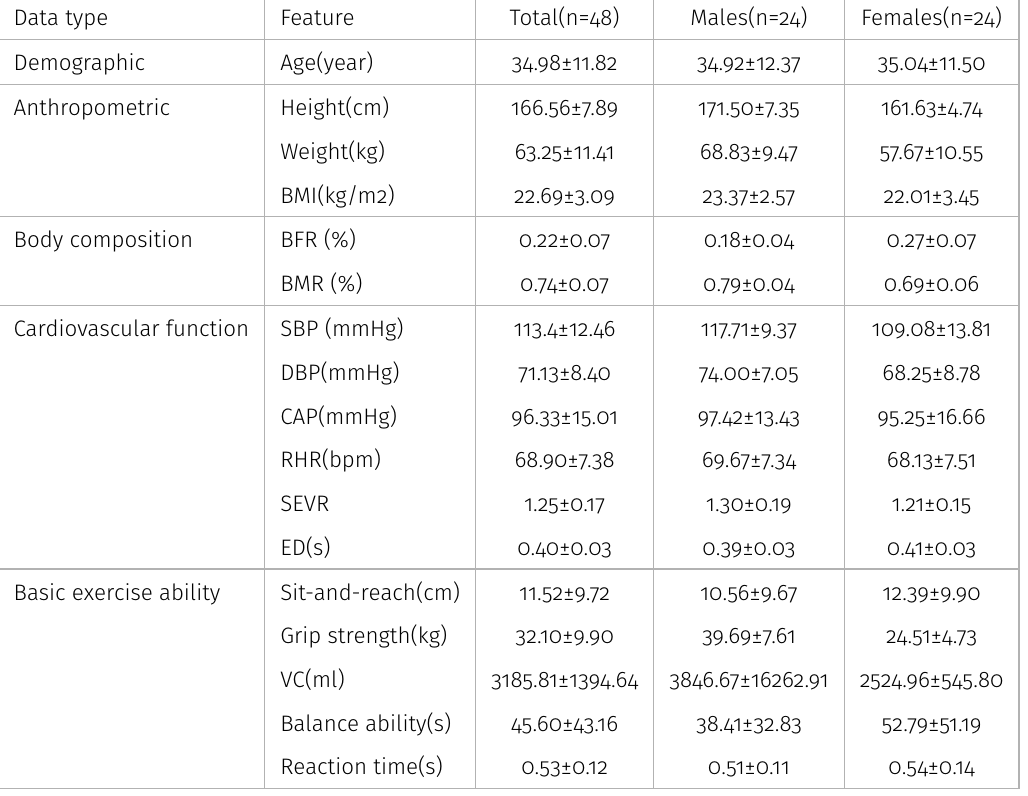
Table I. Baseline characteristics (mean ±SD) of